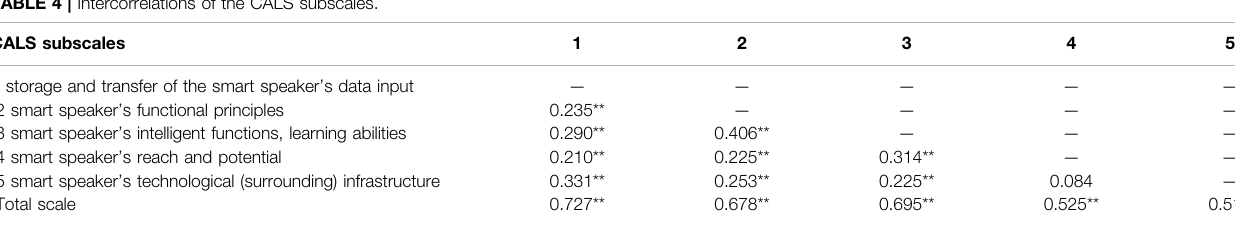
(factor 2). Corrected item scale correlation indicates item discrimination ranging from 0.22 to 0.541.